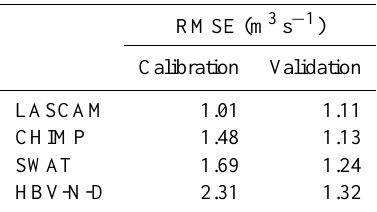
Table 2. Model calibration (1989–1997) and validation (1998– 2006) results for